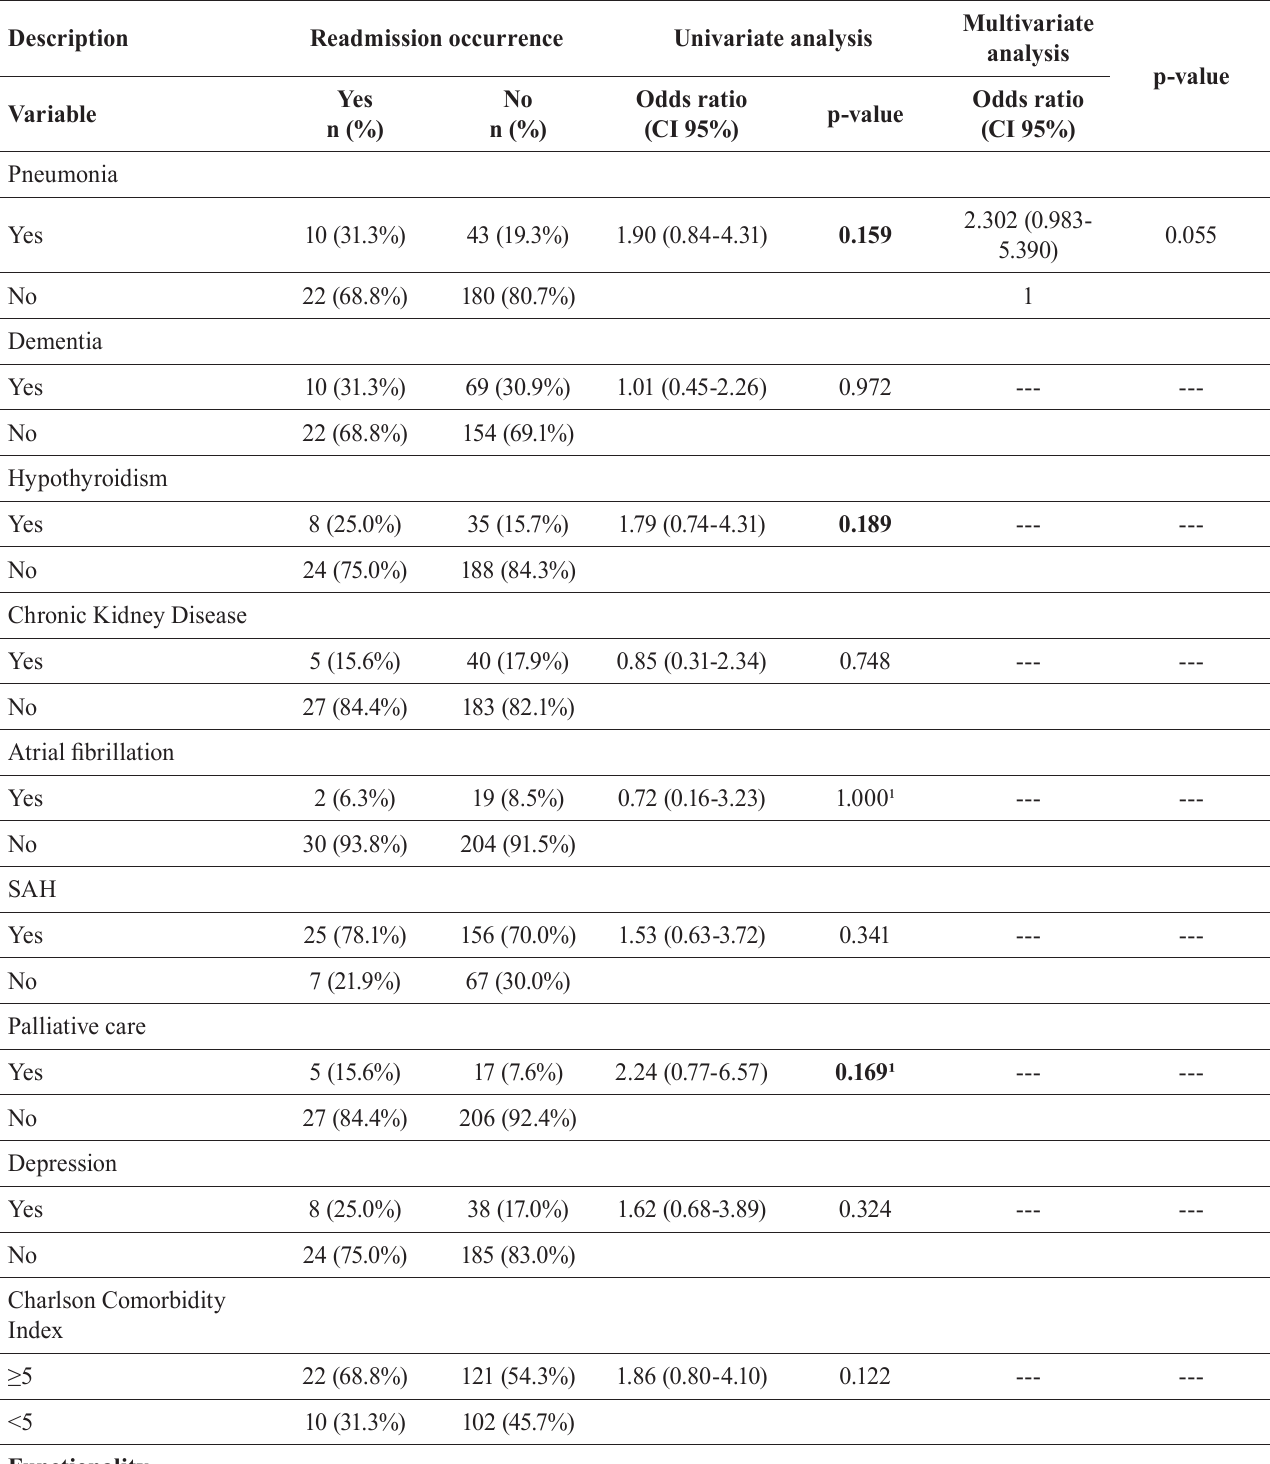
TABLE II – Univariate and multivariate analysis of the factors associated with the occurrence of readmission of older adults